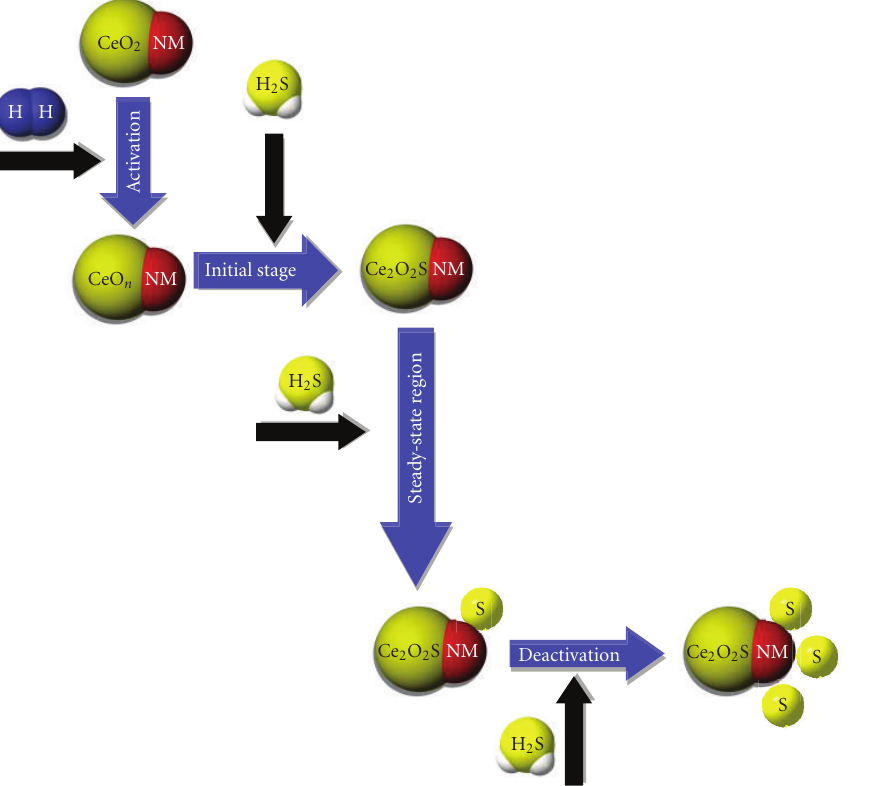
Figure 14: Phenomenological mechanism operative in the monometal supported